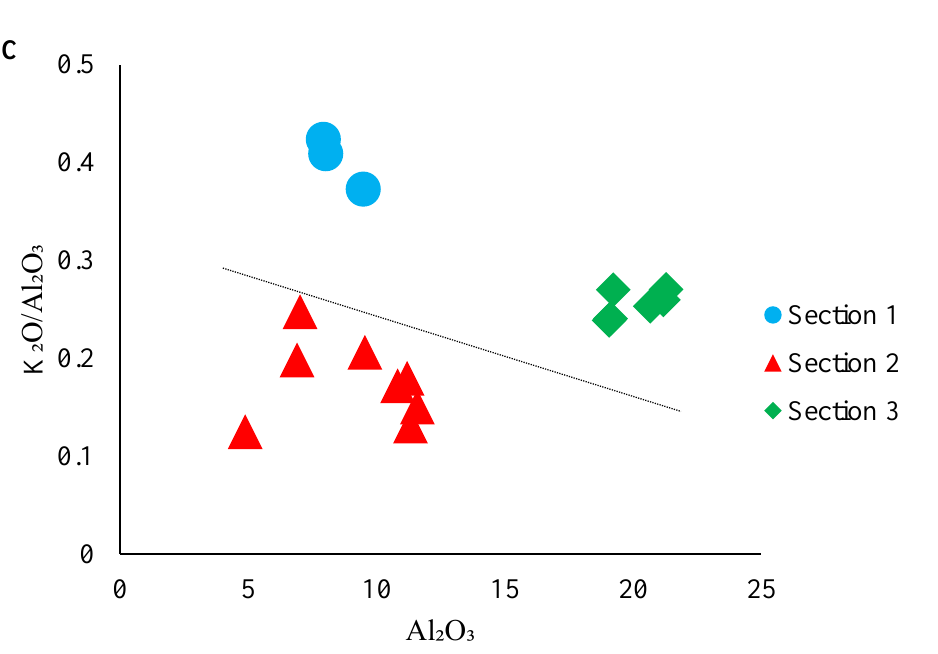
Figure 16. Plots of Al 2 O 3 against ( A ): Fe 2 O 3 /Al 2 O 3 ratio, ( B ): SiO 2 /Al 2 O 3 ratio, and ( C ): K 2 O/Al 2 O 3 .